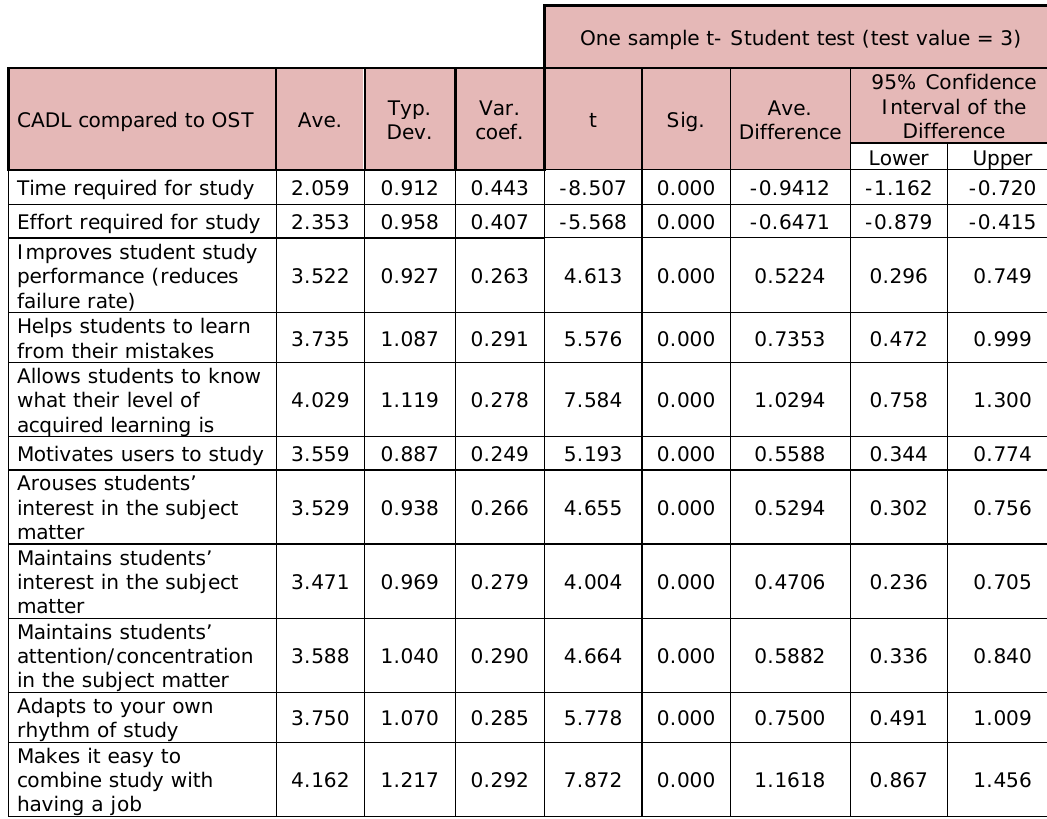
Table 10. “CADL compared to OST: One sample t-Student